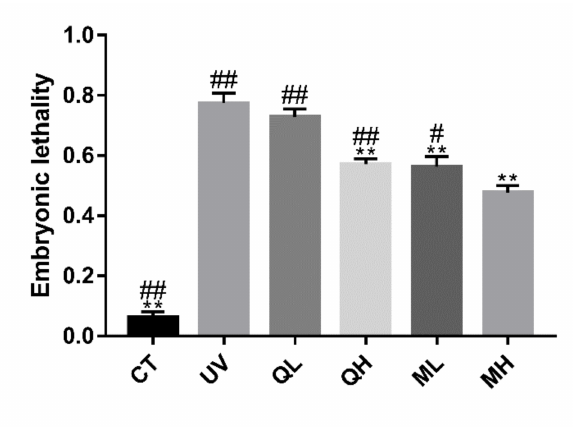
Figure 6. Results of embryonic lethality of every group after UV-B irradiation (100 J / M 2 ). All data are mean ± SEM and were analyzed by two-tailed Student’s t -test, n = 6, * p < 0.05, ** p < 0.01 compared to UV group. # p < 0.05, ## p < 0.01 compared to MH group.